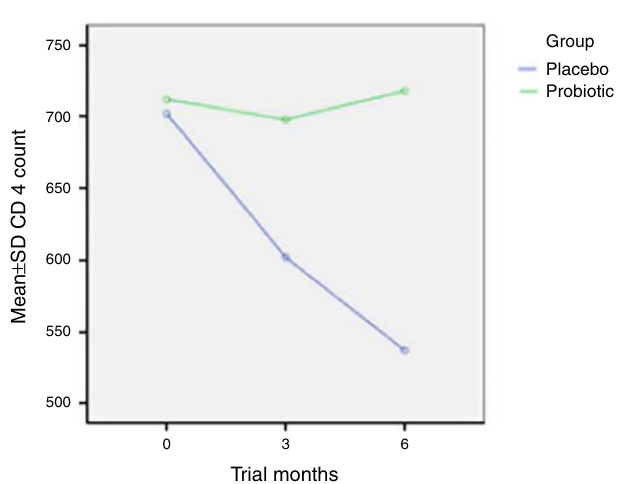
Figure 4. Repeated measure